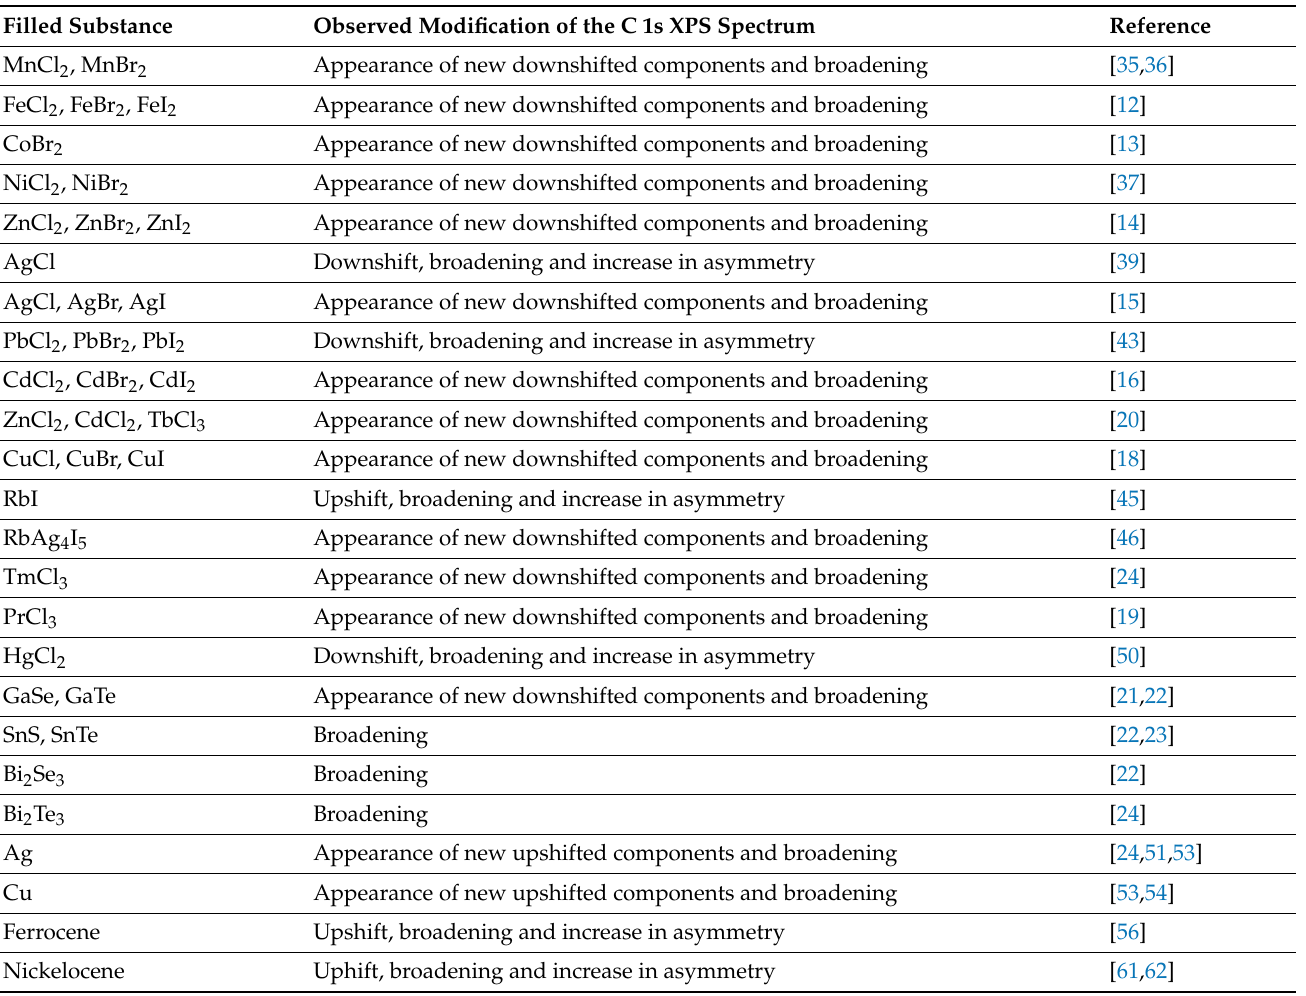
Table 3. Summary of doping-induced modifications of the C 1s XPS spectra of filled